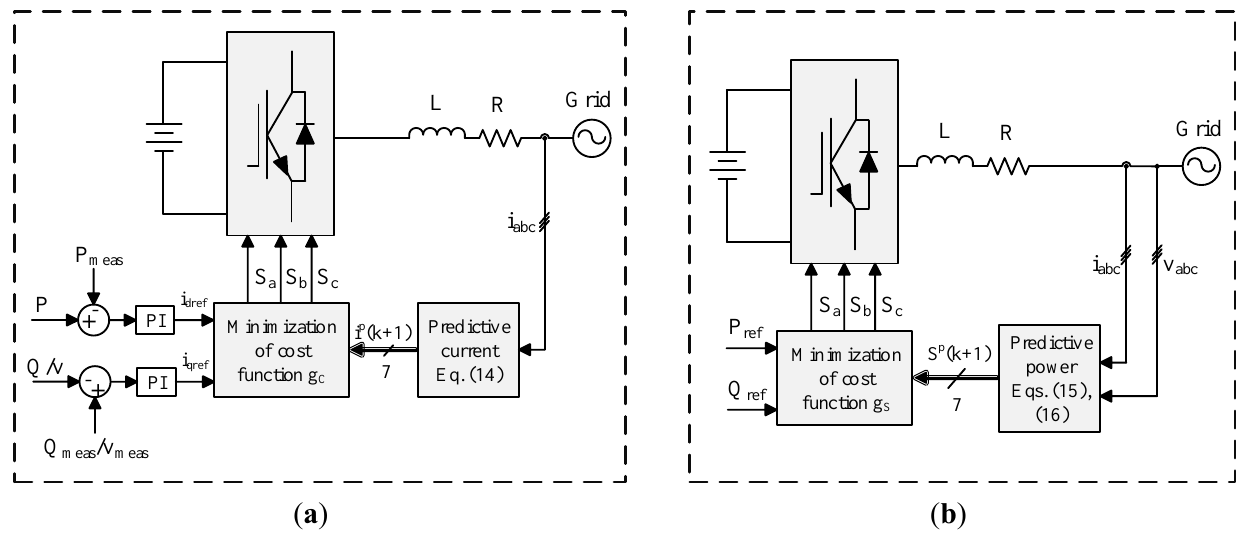
Figure 3. MPC block diagrams: ( a ) MPC based on PI control in the outer and PCC in the inner control loops; ( b ) MPC based on